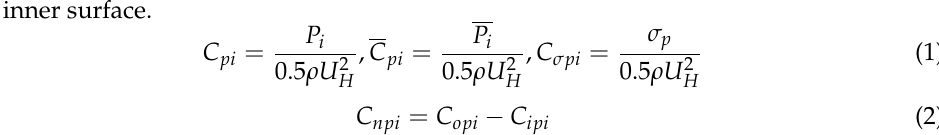
Figure 4. Cross-sectional dimension of each measuring point layer.